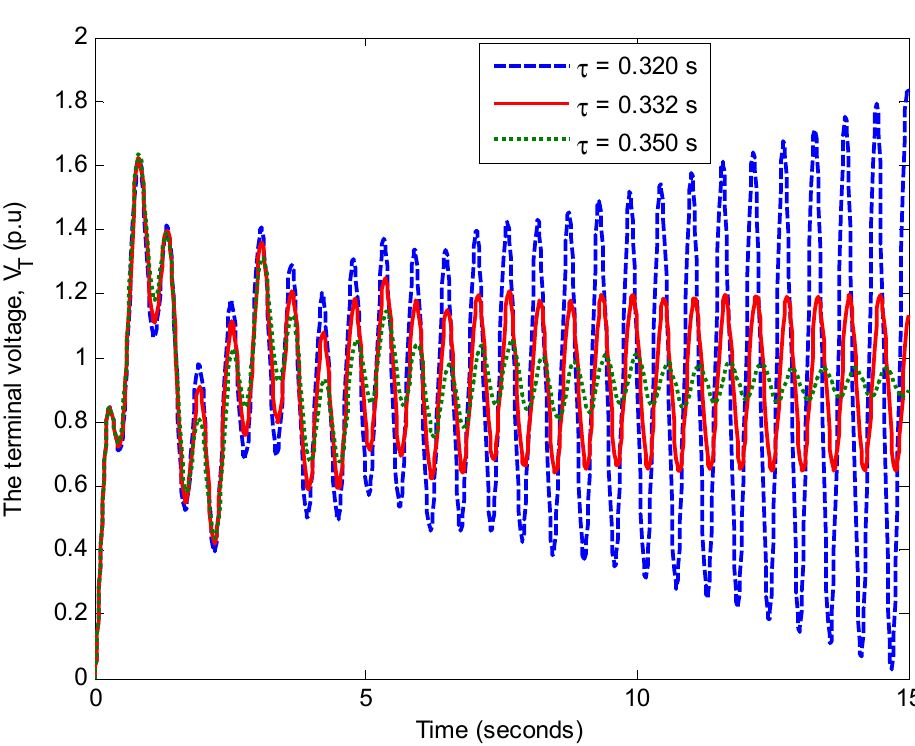
Figure 12. The terminal voltage with different time delays.